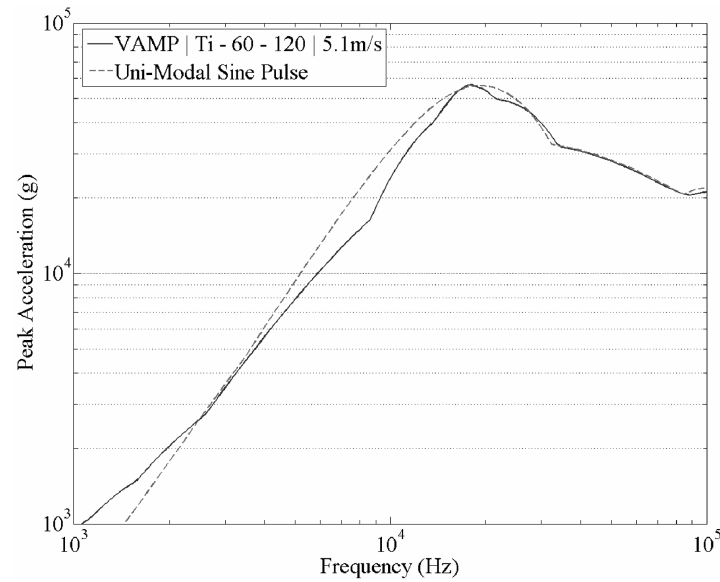
Fig. 11. SRS for VAMP and uni-modal sine pulse.